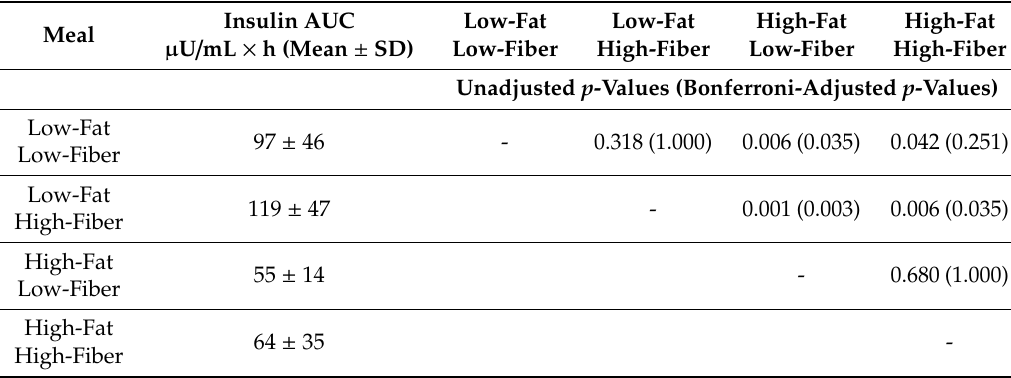
Figure 4. Plasma insulin as area under curve (AUC) over 4 h, in response to the four meals. Boxes for each meal represent the interquartile range. Minimum and maximum values are indicated at the tips of each vertical line. The median for each meal is depicted by the horizontal line within each box. See Table 6 for statistical comparisons between meals. Table 6. Plasma insulin area under curve (AUC): comparisons between meals.